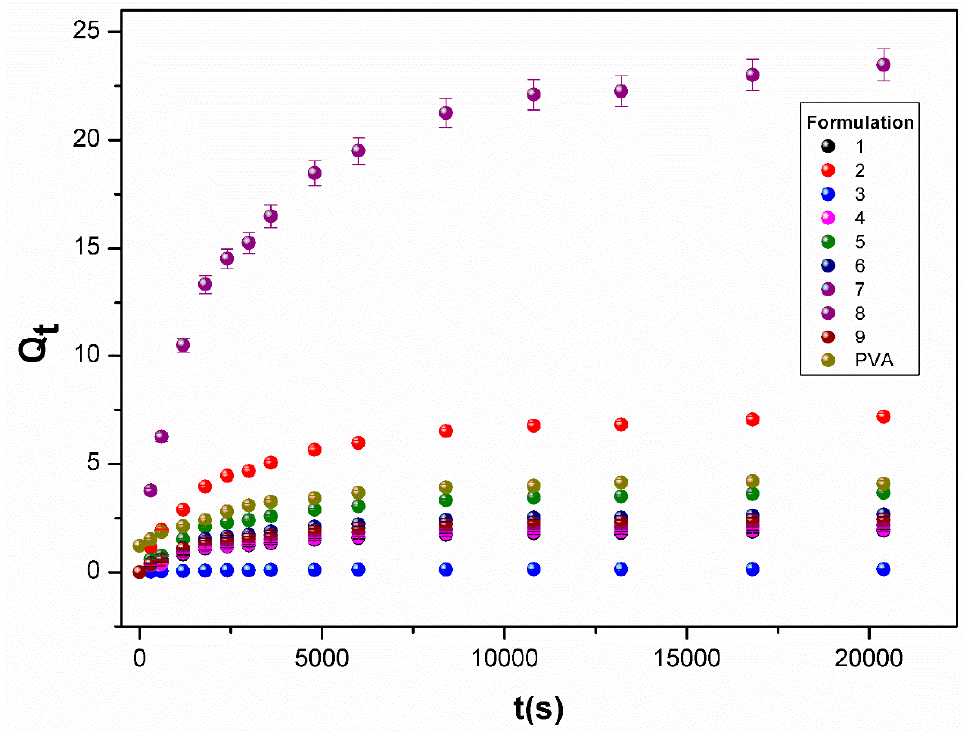
Figure 3. Swelling kinetics of PVA/CS/MA- β -CD composite hydrogels (see Table S2 in water, at 25 °C.